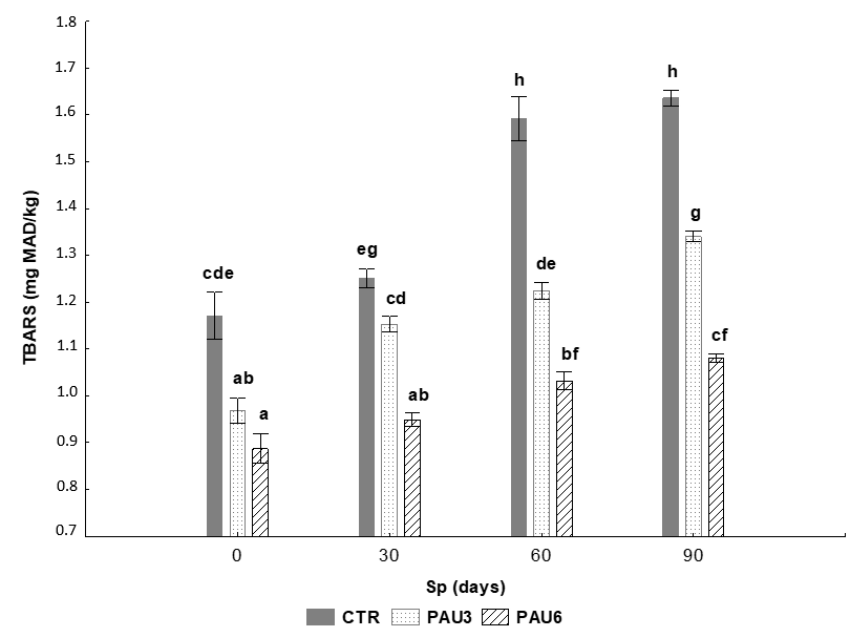
Figure 2. Effect of A. unedo fruits extracts on thiobarbituric acid reacting substances (TBARS) of limpets pâté samples (CTR—with synthetic additive; PAU3—with 3% of A. unedo fruits extract; PAU6—with 6% of A. unedo fruits extract) stored at refrigerated temperature for 90 days. Bars with different letters represent significant differences ( p -value < 0.05). Error lines represent the standard deviation.